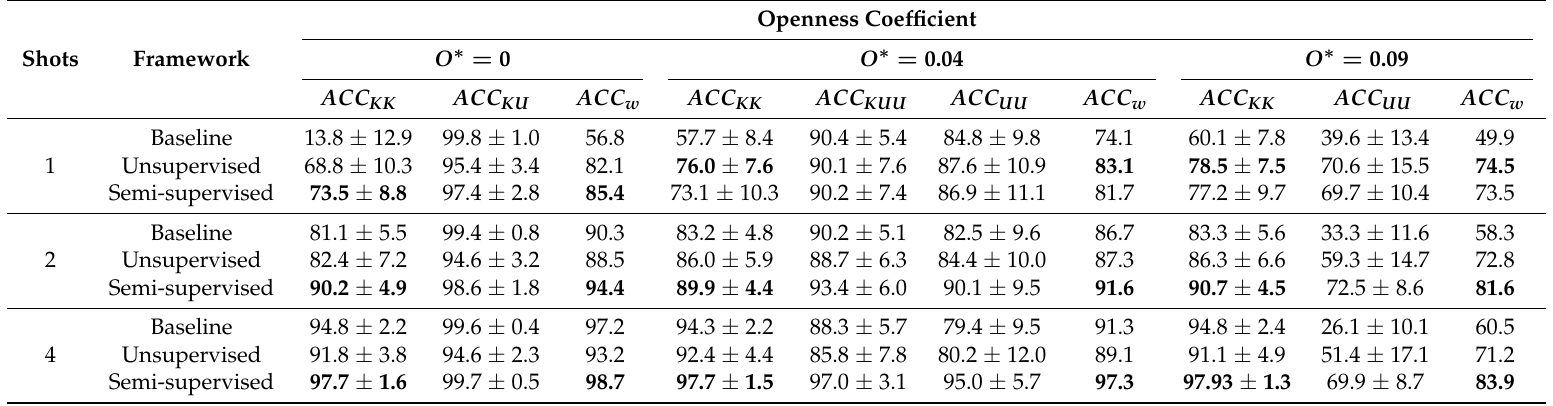
Table 3. Final classification results (%). Baseline results correspond to the L3 approach framework presented in [22]. The bold numbers indicate winning configurations according to the number of